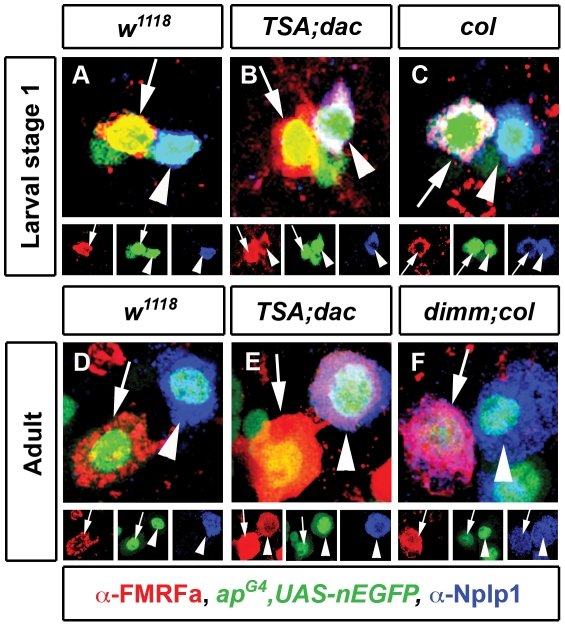
Differentiation networks have different abilities to activate ectopic gene expression in adult neurons.(A–F) Representative images of Tv4 neurons (arrows) and Tv1 neurons (arrowheads) at larval stage 1 (A–C) and adults (D–F). (B,E) Induction of ectopic FMRFa expression (arrowhead, red) in Tv1 (identified with Nplp1, blue) after misexpression of dac and constitutively-activated Thickveins and Saxophone BMP receptors (TSA) in embryos (B n = 33) and for 5 days in adults (E n = 31). (C) Misexpression of col in embryonic Tv neurons using apGal4 initiates ectopic Nplp1 expression (arrow, blue) in Tv4 neurons (identified with FMRFa, red) (C n = 24). (F) Misexpression of col and upregulation of dimm for 5 days in adults using apGal4 initiates ectopic Nplp1 expression (arrow, blue) in Tv4 neurons (identified with FMRFa, red) (F n = 42). Genotypes: (A–C) Larval stage 1 w1118 (apGal4/+; UAS-nEGFP/+); TSA;dac (apGal4/UAS-tkvA, UAS-saxA; UAS-nEGFP/UAS-dac); col (apGal4/UAS-col; UAS-nEGFP/+). (D-F) Adult w1118 (apGal4/+; tub-Gal80TS, UAS-nEGFP/+); TSA;dac (apGal4/UAS-tkvA, UAS-saxA; tub-Gal80TS, UAS-nEGFP/UAS-dac); dimm;col (apGal4/UAS-col; tub-Gal80TS, UAS-nEGFP/UAS-dimm).